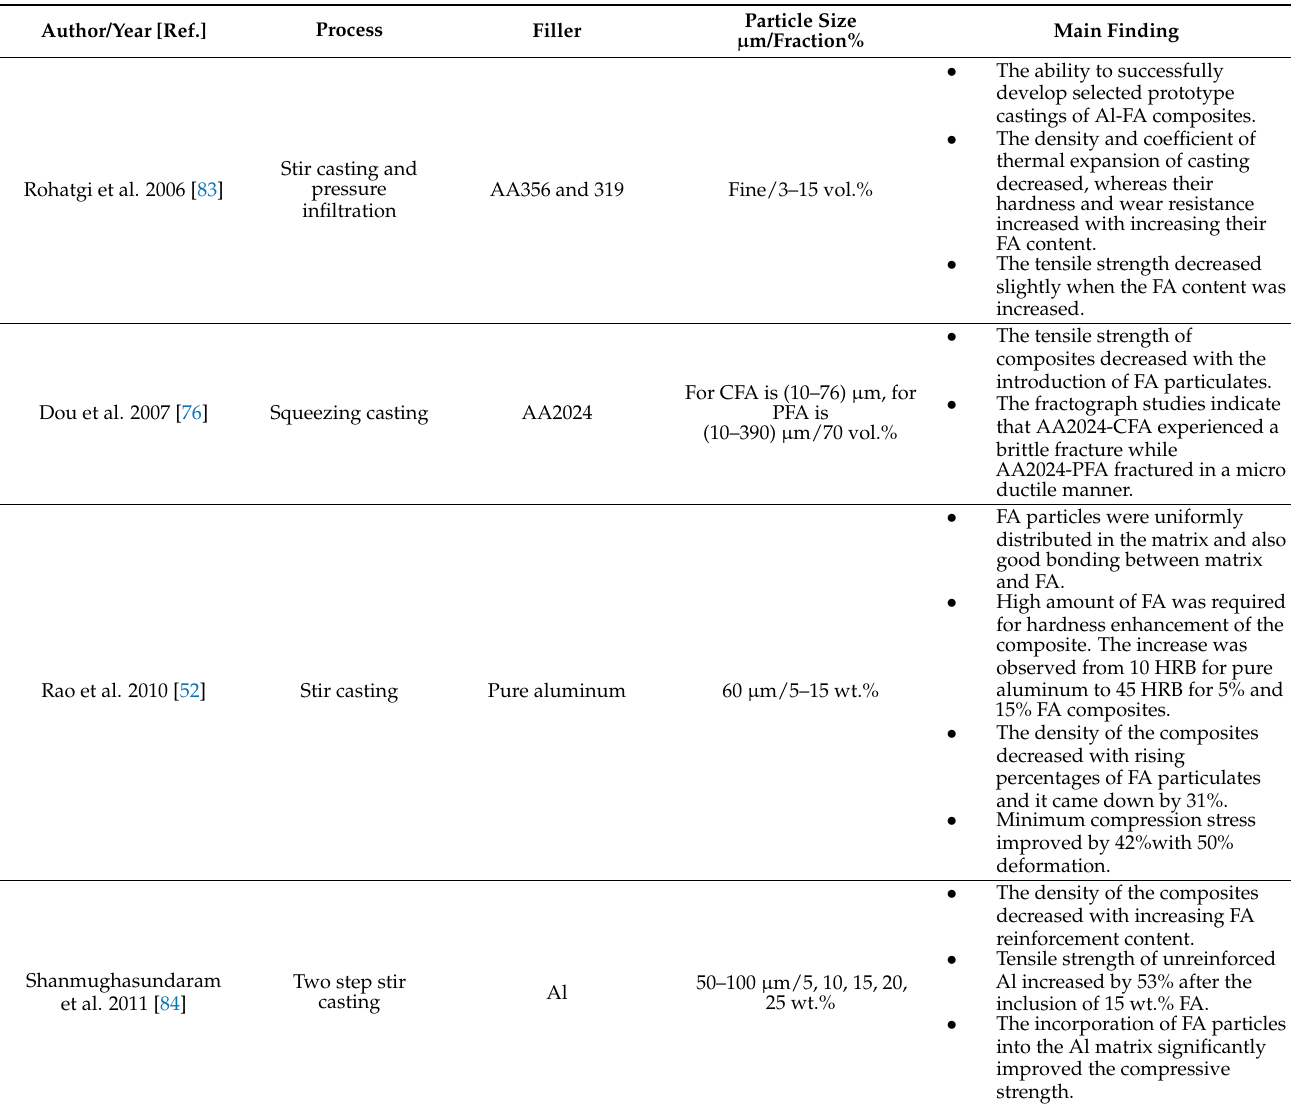
Table 1. Effect FA on physical and mechanical properties of Al-FA